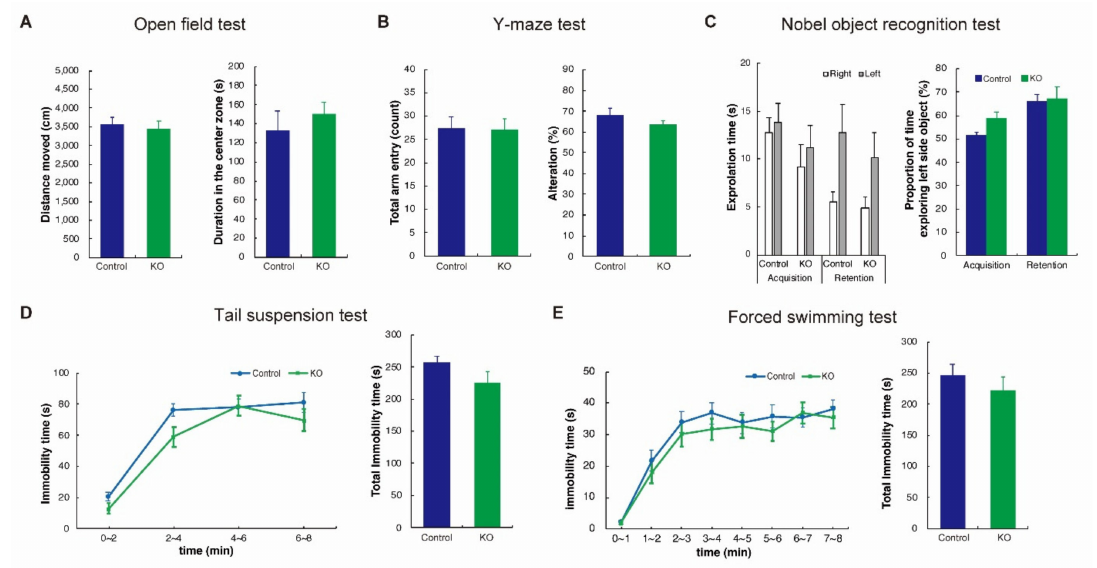
Figure 5. Results of behavioral examinations. ( A ) Results of open field tests. Distance moved and duration in the central zone were used as parameters of spontaneous and anxiety-like behaviors, respectively. ( B ) Results of Y-maze tests. The proportion of entries into di ff erent arms sequentially (alternation) was used as an indicator of short-term memory. ( C ) Results of novel object recognition tests. The proportion of time exploring the left side object in the retention interval was used as an indicator of object recognition memory. The retention session was performed for 24 h after the acquisition session. In the retention session, the left object used in the acquisition session was exchanged with a novel object. ( D ) Results of tail suspension tests. Immobility time was used as an indicator of depression-like behavior. ( E ) Results of forced swimming tests. Immobility time was similarly used as an indicator of depression-like behavior. In all tests, there was no significant di ff erence between controls and HCNP-pp KO mice. Error bar represents